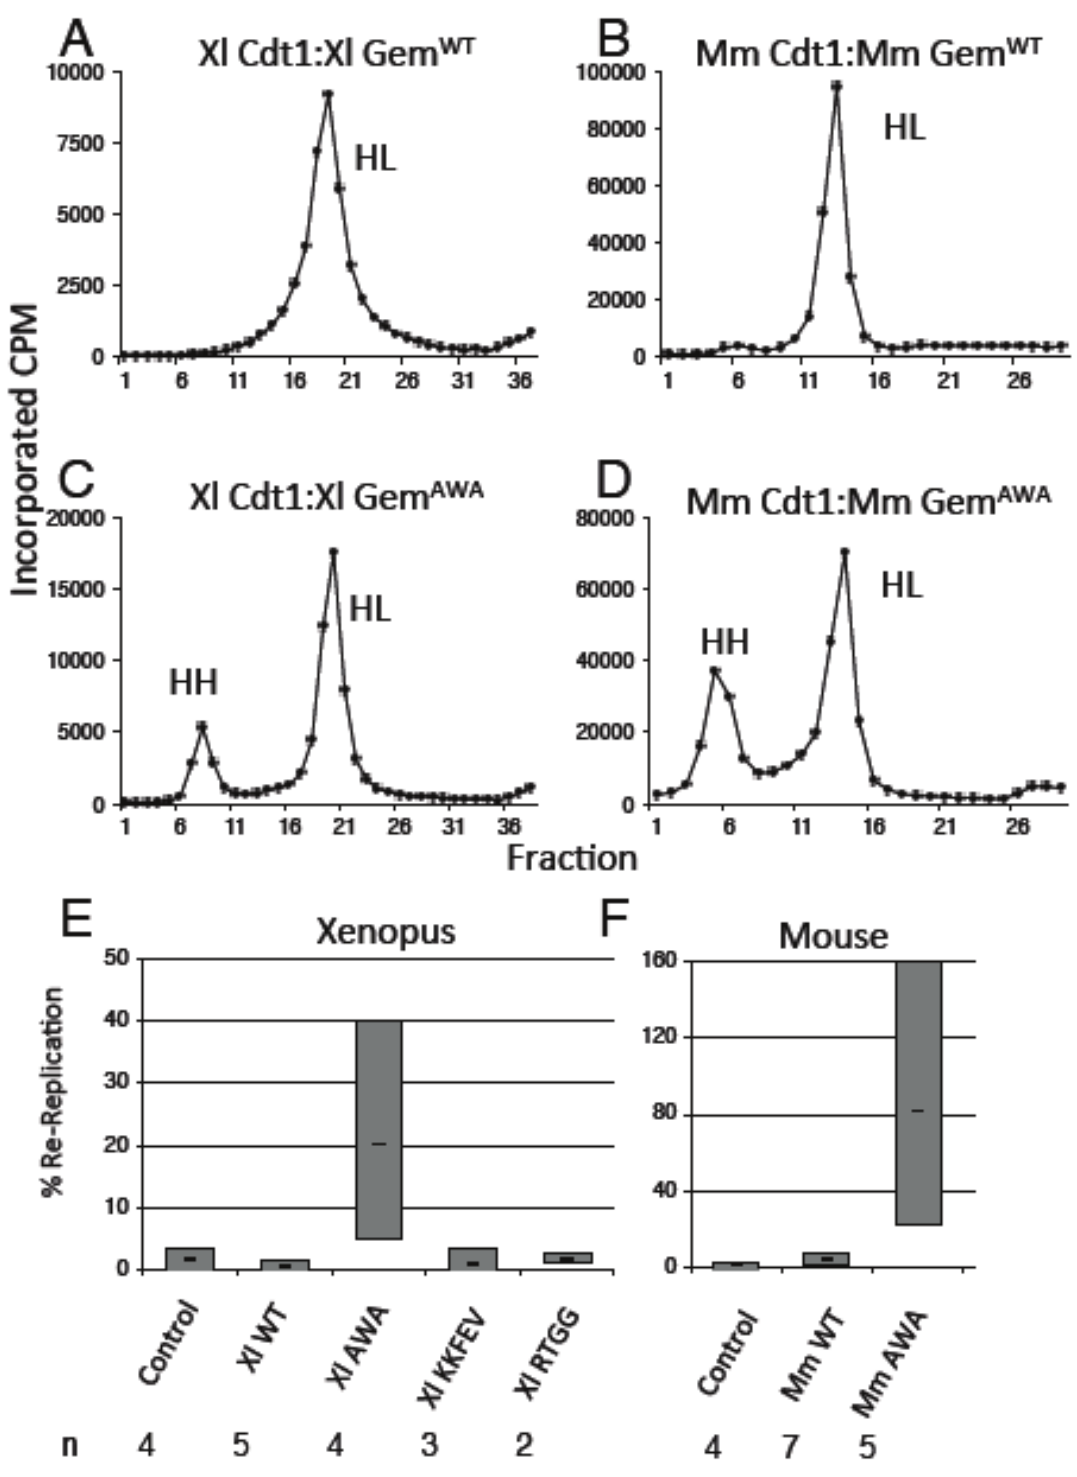
Figure 4. Geminin AWA does not inhibit re-replication. Replication extracts made from Xenopus eggs were depleted of both Geminin and Cdt1 using specific antibodies, then supplemented with recombinant Geminin:Cdt1 complexes. Replication was allowed to progress in the presence of BrdUTP, then the density of the product was determined by equilibrium ultracentrifugation. ( A – D ) Typical gradient profiles; ( E ) extent of re-replication for different Geminin mutants. The gray bar indicates the range, and the horizontal line indicates the mean. n, number of